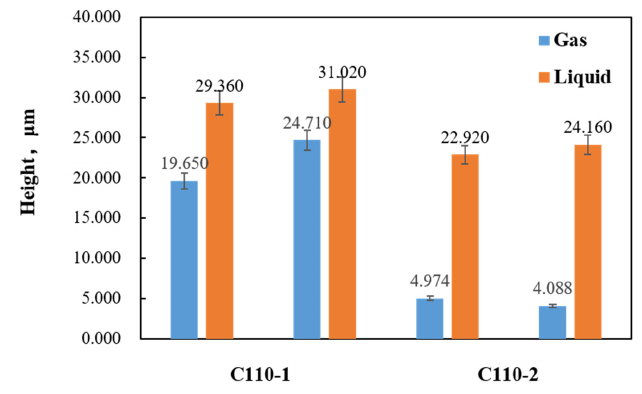
Figure 20. Height of pits.